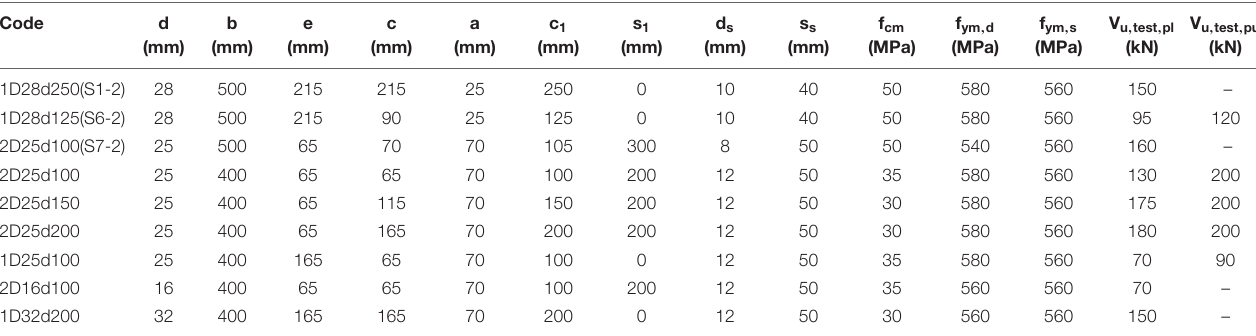
TABLE 2 | Evaluated test